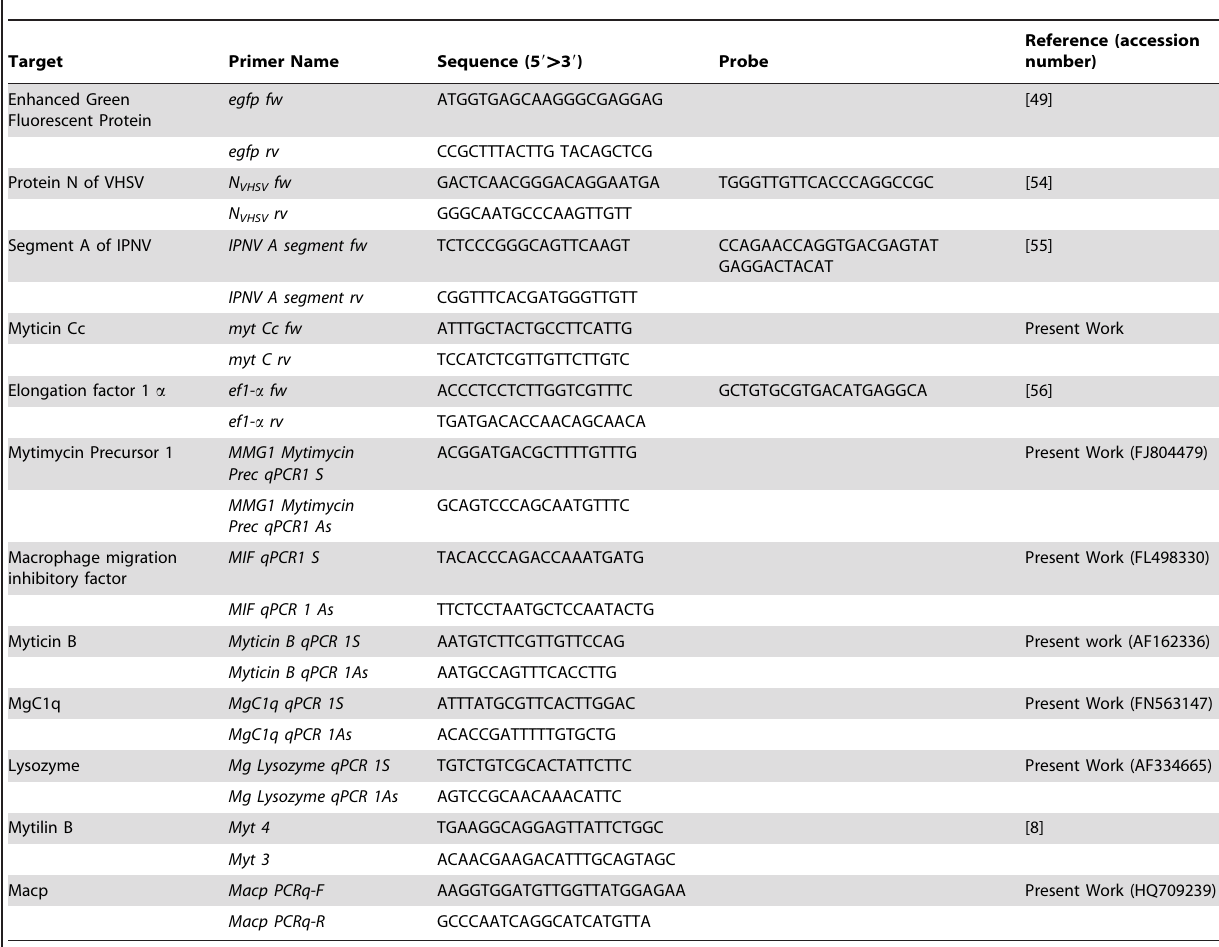
Table 2. Sequences of primers and probes for